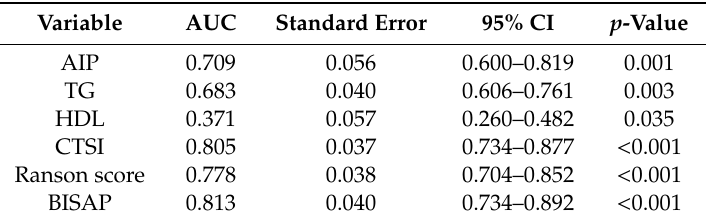
Table 2. Area under the curve for predicting severe acute